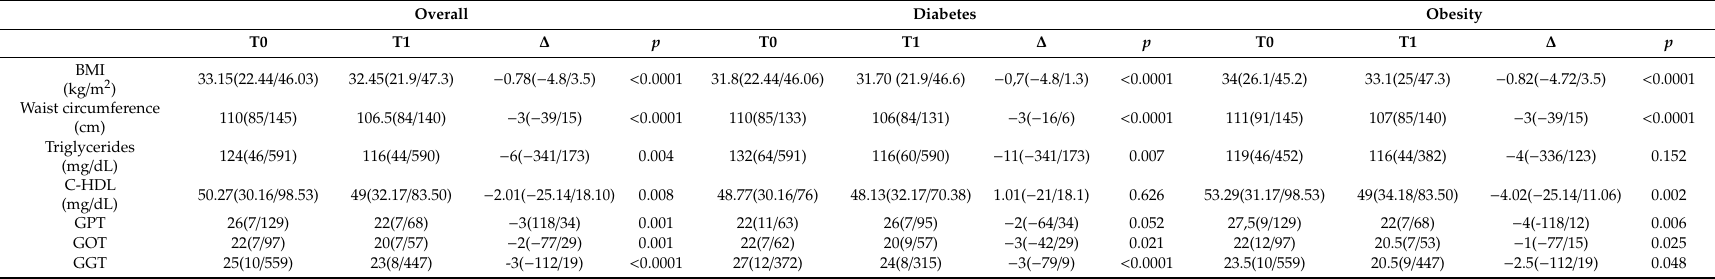
Table 1. All the features that contribute to the definition of the various indices, at baseline (T0) and after three months (T1) of intensive lifestyle program. Overall Diabetes